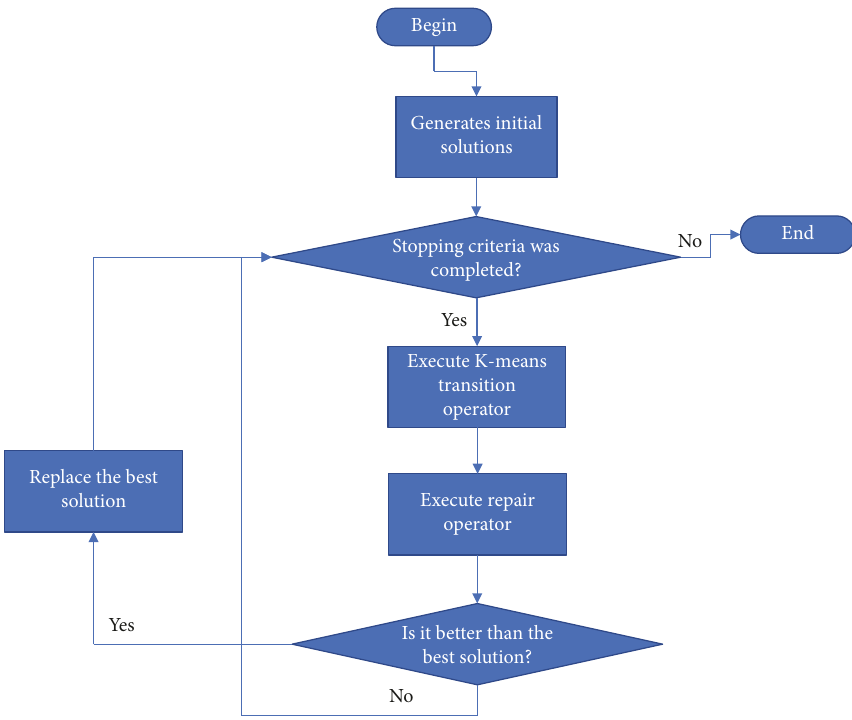
Figure 2: Binary cuckoo search algorithm fl ow chart.